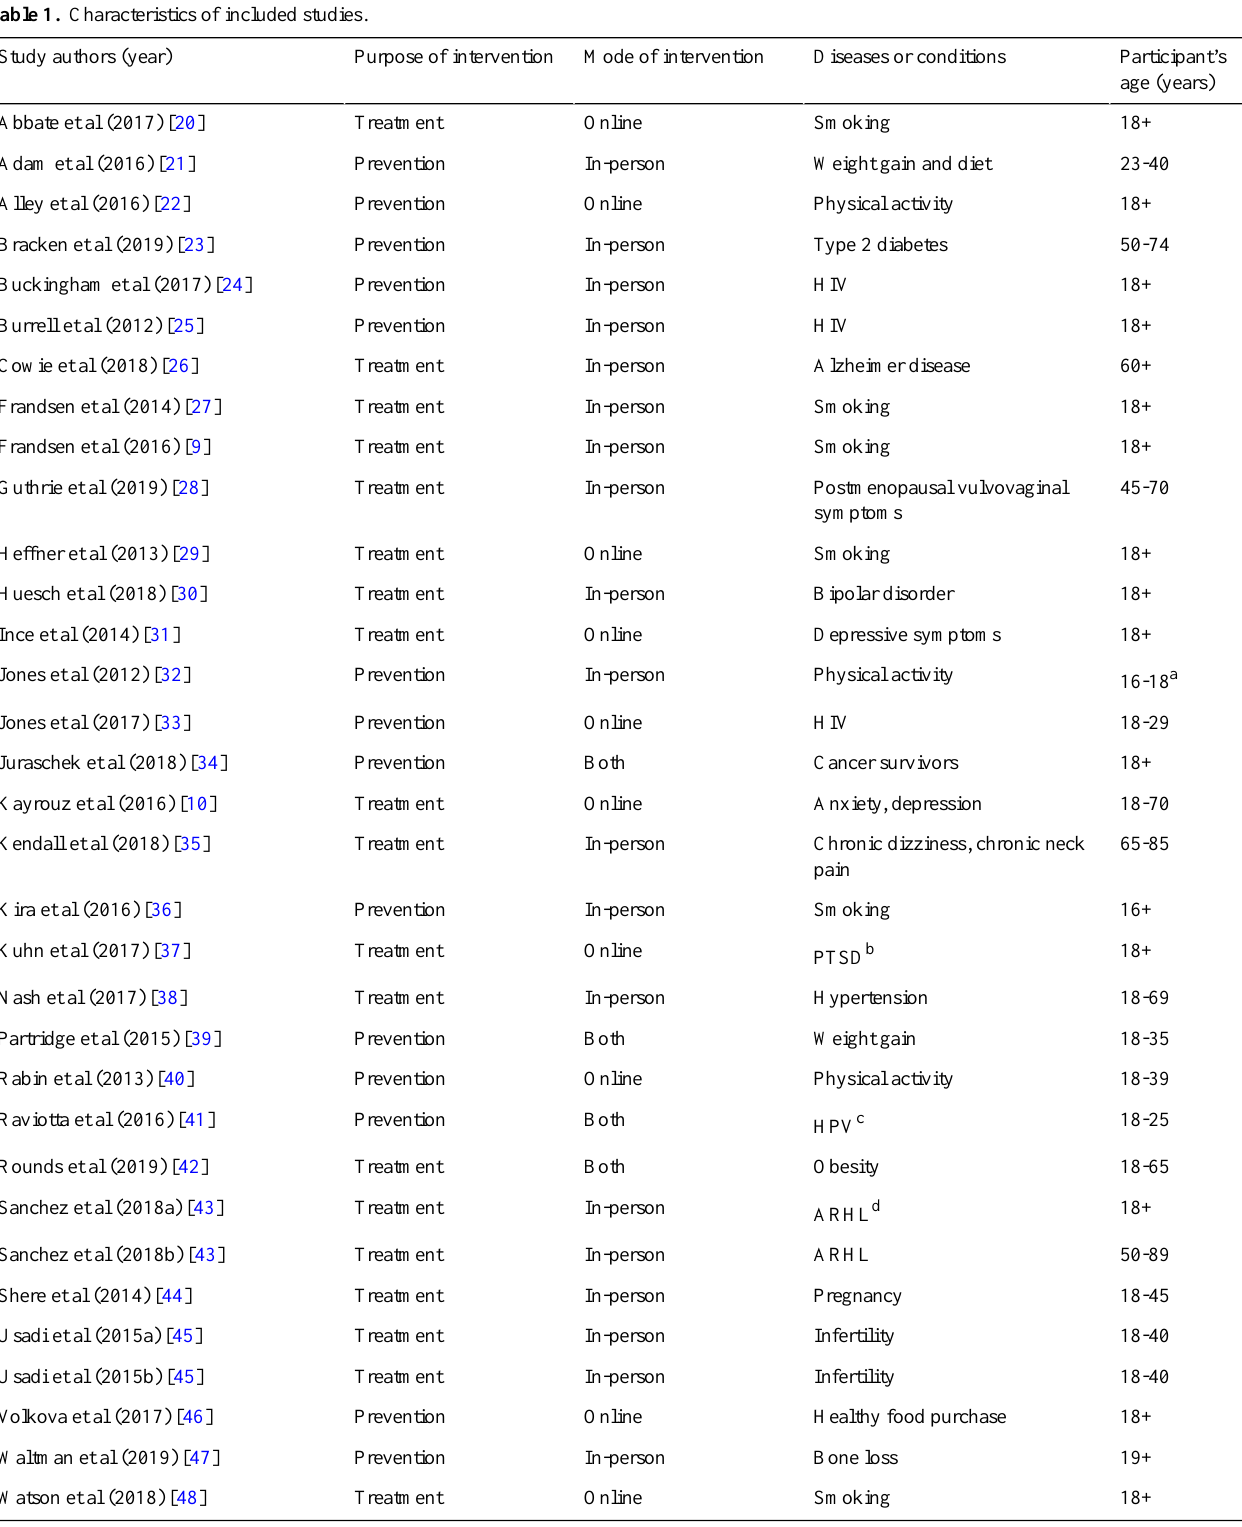
Table 1. Characteristics of included studies.